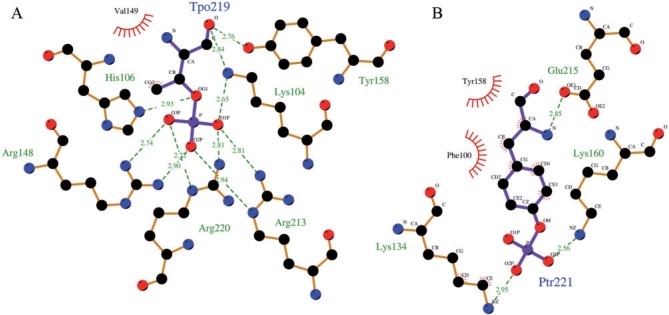
pT- and pY-binding pockets in SpvC. Schematic depiction of pT (A) and phosphotyrosine (B) binding pocket in SpvC crystal structure [PDB: 2Q8Y]. For clarity, only interactions with phosphorylated residues are shown. The plot was generated using LigPlot+ (Laskowski and Swindells 2011).